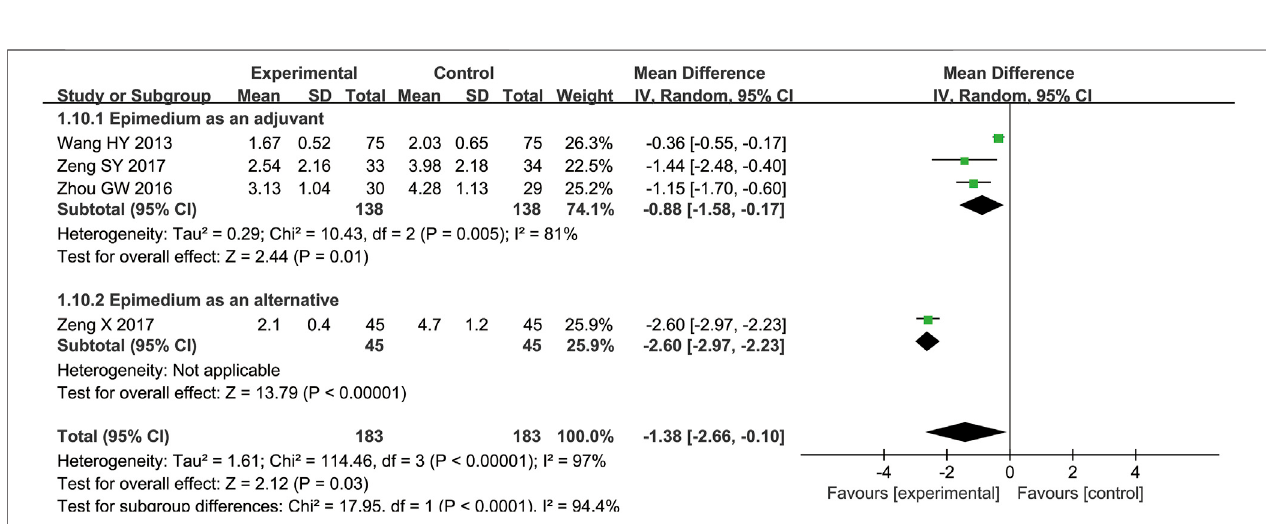
FIGURE 5 | Meta-analysis results of the effect of Epimedium vs conventional pharmacotherapy on VAS.